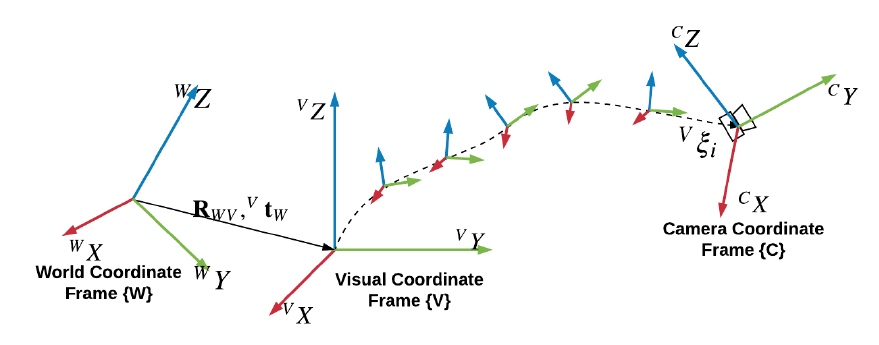
Figure 3. World, visual, and camera coordinate